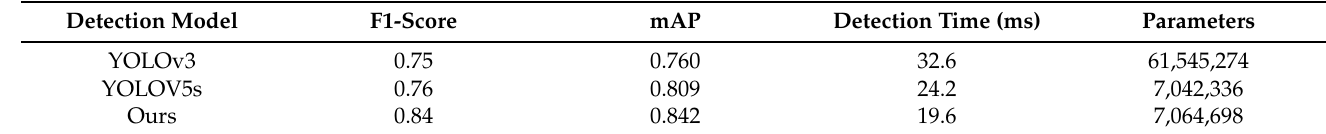
Figure 10. The effect of complex environment detection under daylight. Where ( a ) shows the original figure; ( b ) shows our proposed improved YOLOv5s network detection effect; ( c ) shows YOLOv5s detection effect; ( d ) shows YOLOv3 detection effect. Table 2. Comparison of mAP, F1 score, detection speed and parameter quantity of different models.